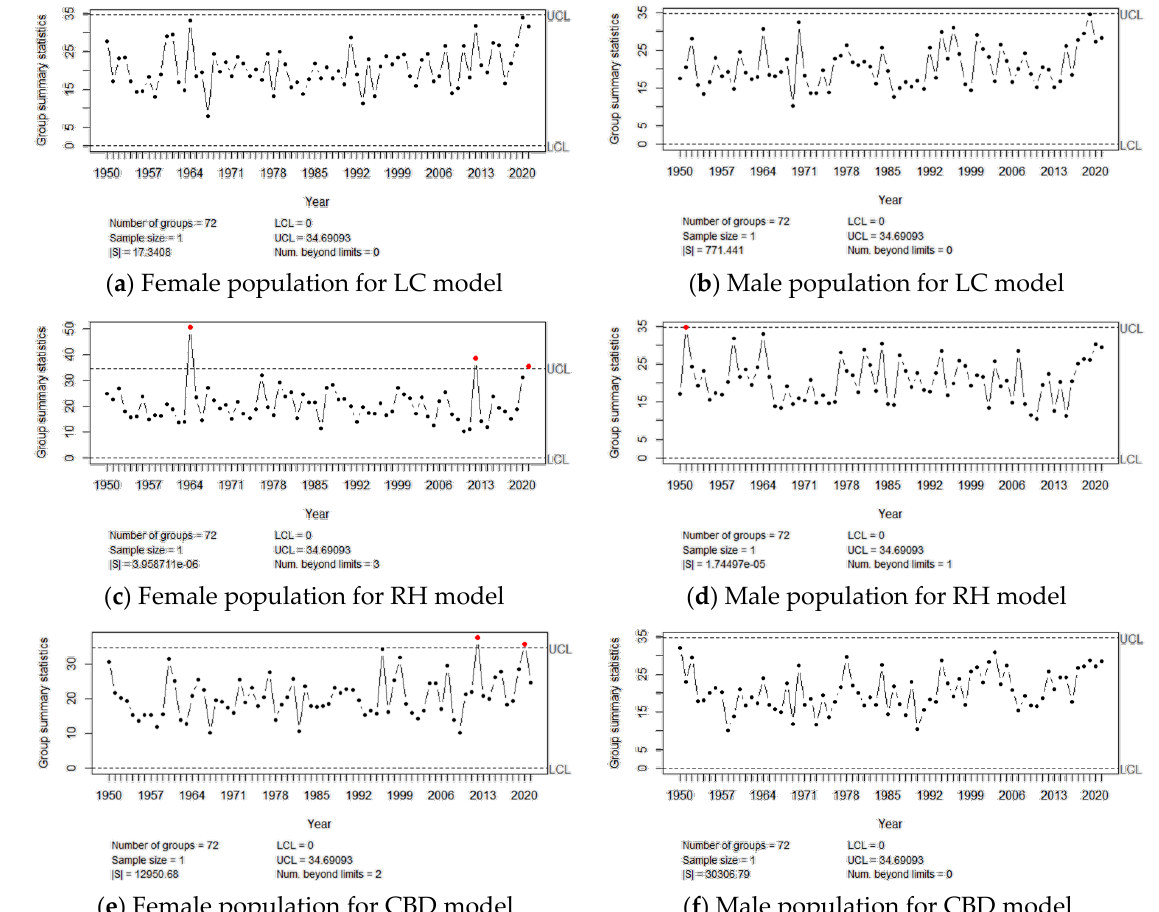
Figure 6. Hotelling T 2 control charts for all models after DT.